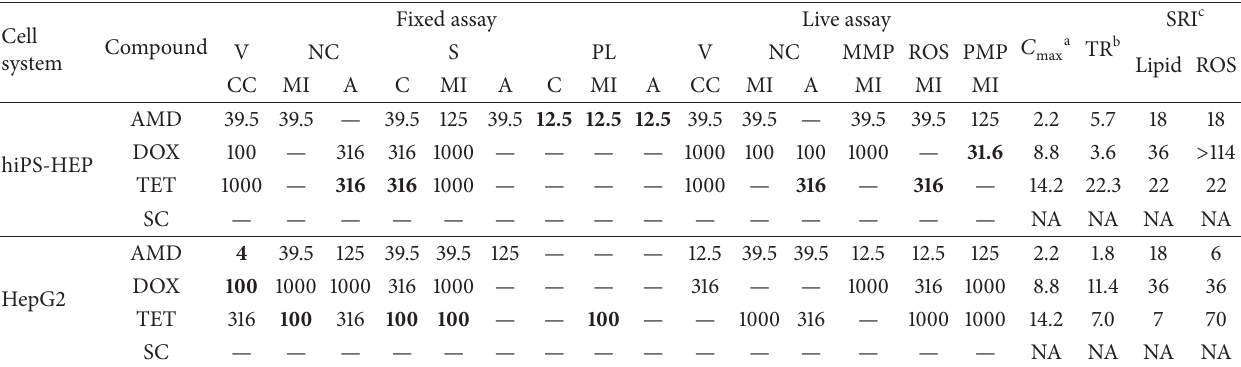
Table 3: Cytotoxic effects of the tested compounds in hiPSC derived hepatocytes (hiPS-HEP) and HepG2: minimal effective concentration and toxicity risk steatotic risk